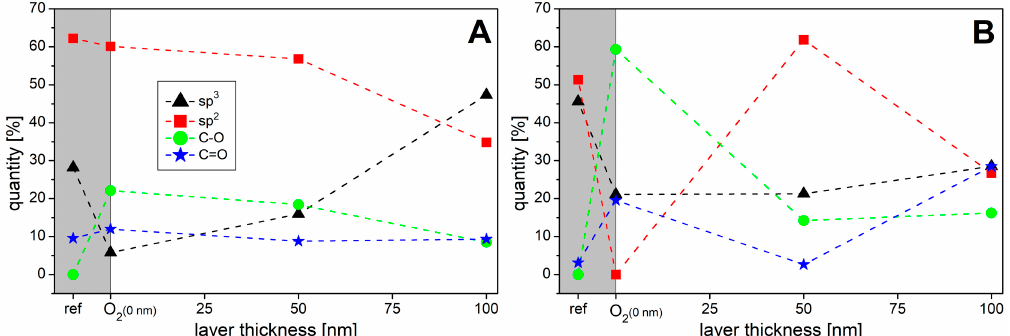
Figure 5. XPS measurements for CS ( A ) and CN–CS ( B ). Data are shown for the raw polymer (ref), O 2 plasma treated (representing the layer thickness of 0 nm), and plasma-coated samples of 50 and 100 nm a–C:H. The dashed lines only indicate a trend. The grey box includes the O 2 plasma pretreatment of each raw